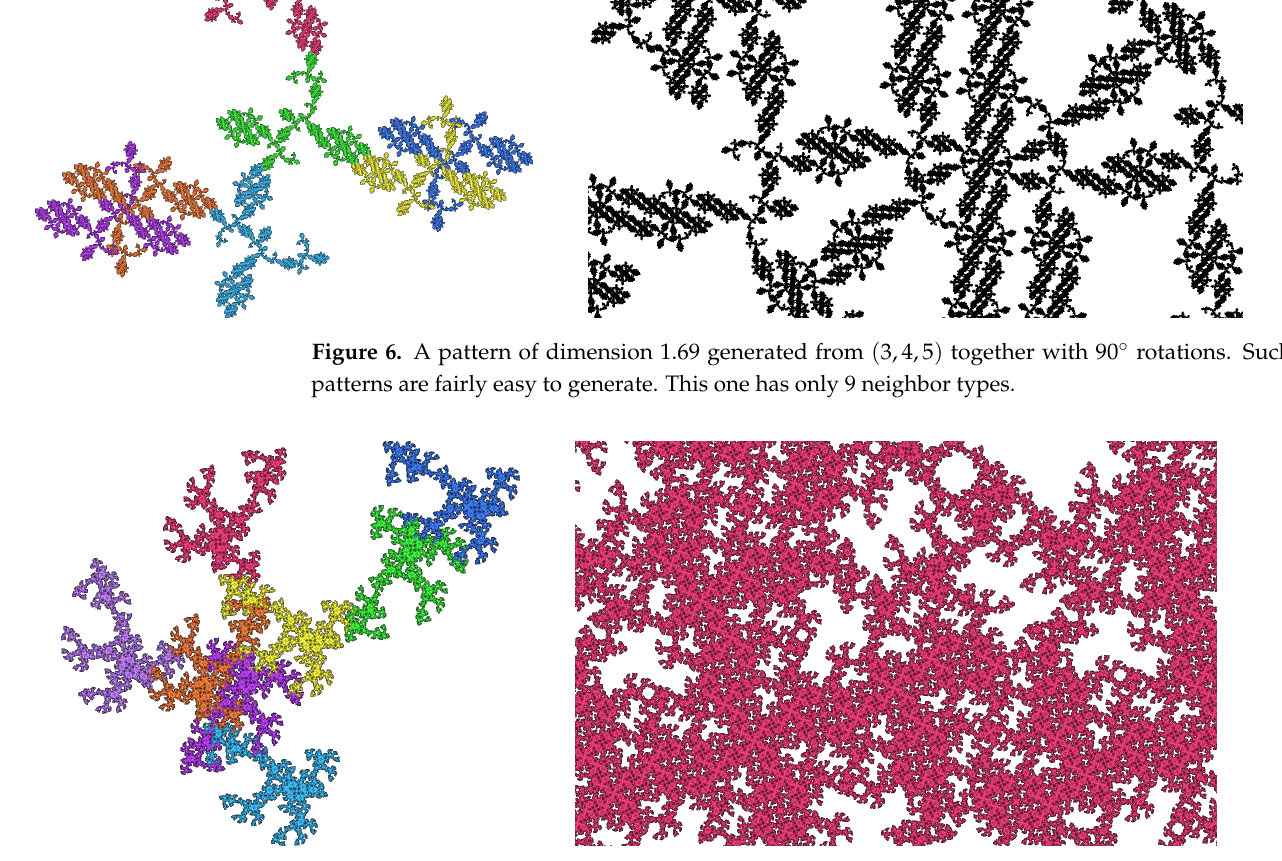
Figure 7. A carpet generated from ( 3,4,5 ) together with 90 ◦ rotations. The expansion has determinant 10, and there are m = 8 pieces. The Hausdorff dimension is 1.81, the intersections of pieces have dimension 1.25, and there are 13 neighbor